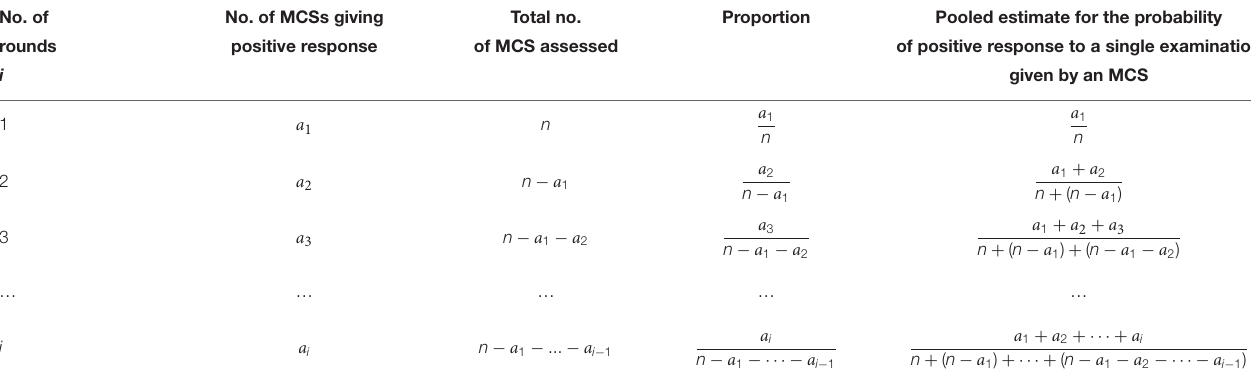
TABLE 1 | Pooled estimate for the probability of positive response to a single examination given by an MCS patient in theory. No. of No. of MCSs giving Total no. Proportion Pooled estimate for the probability rounds positive